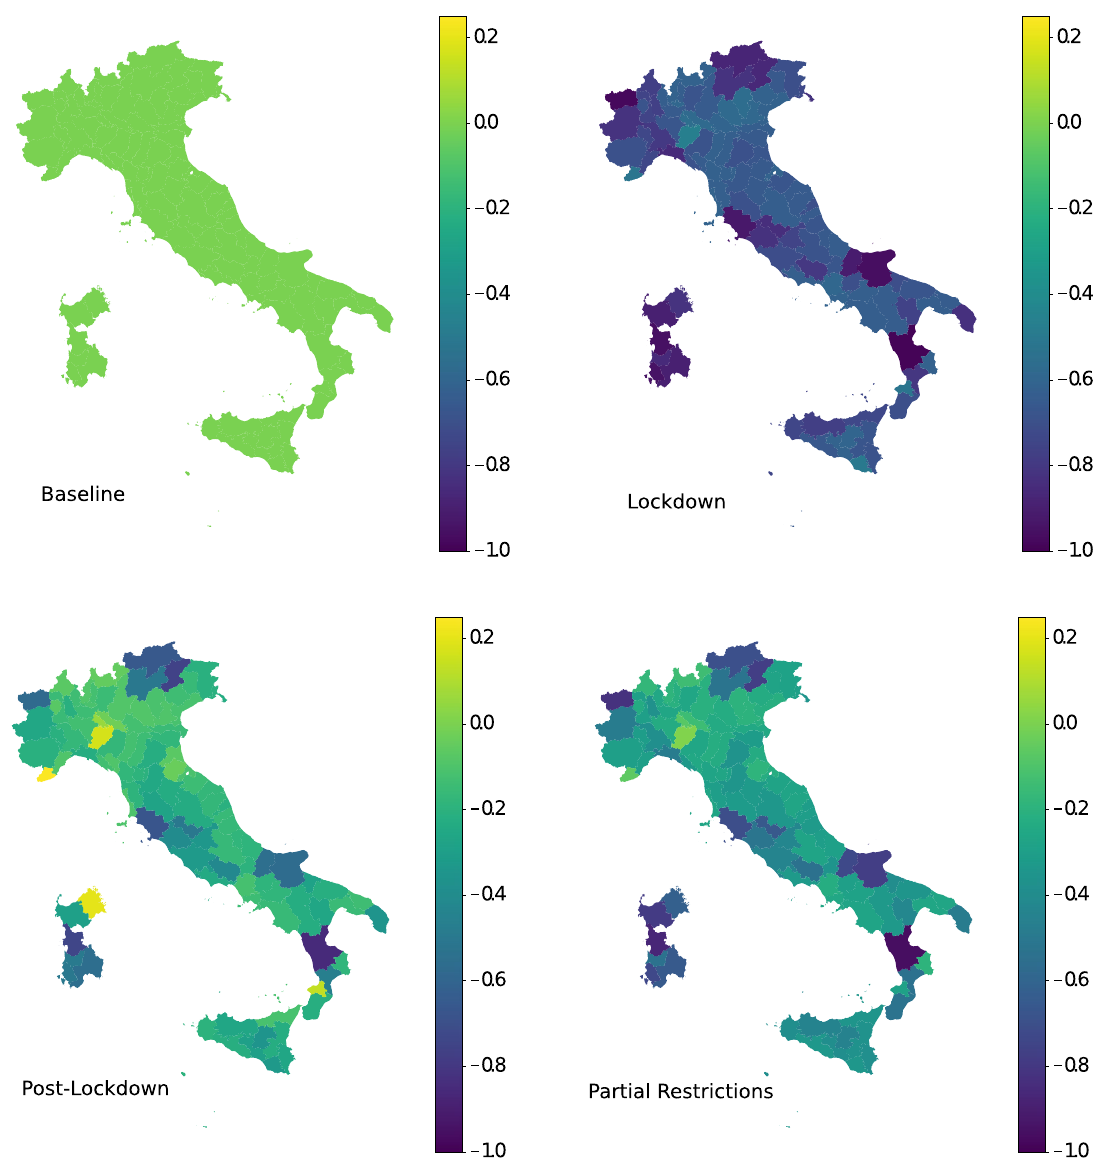
Figure 3. Clockwise from top-left: Baseline map of Italian Provinces; Reduction in mobility during Lockdown; Partial lift of limitations; All limitations lifted. The color bar indicates the reduction in weighted degree for each Province, with darker blue meaning stronger reduction. The lower panels show the gradual “return to normal”, with the majority of Provinces behaving similarly, but a few noticeable outliers as described in the main text and Fig.